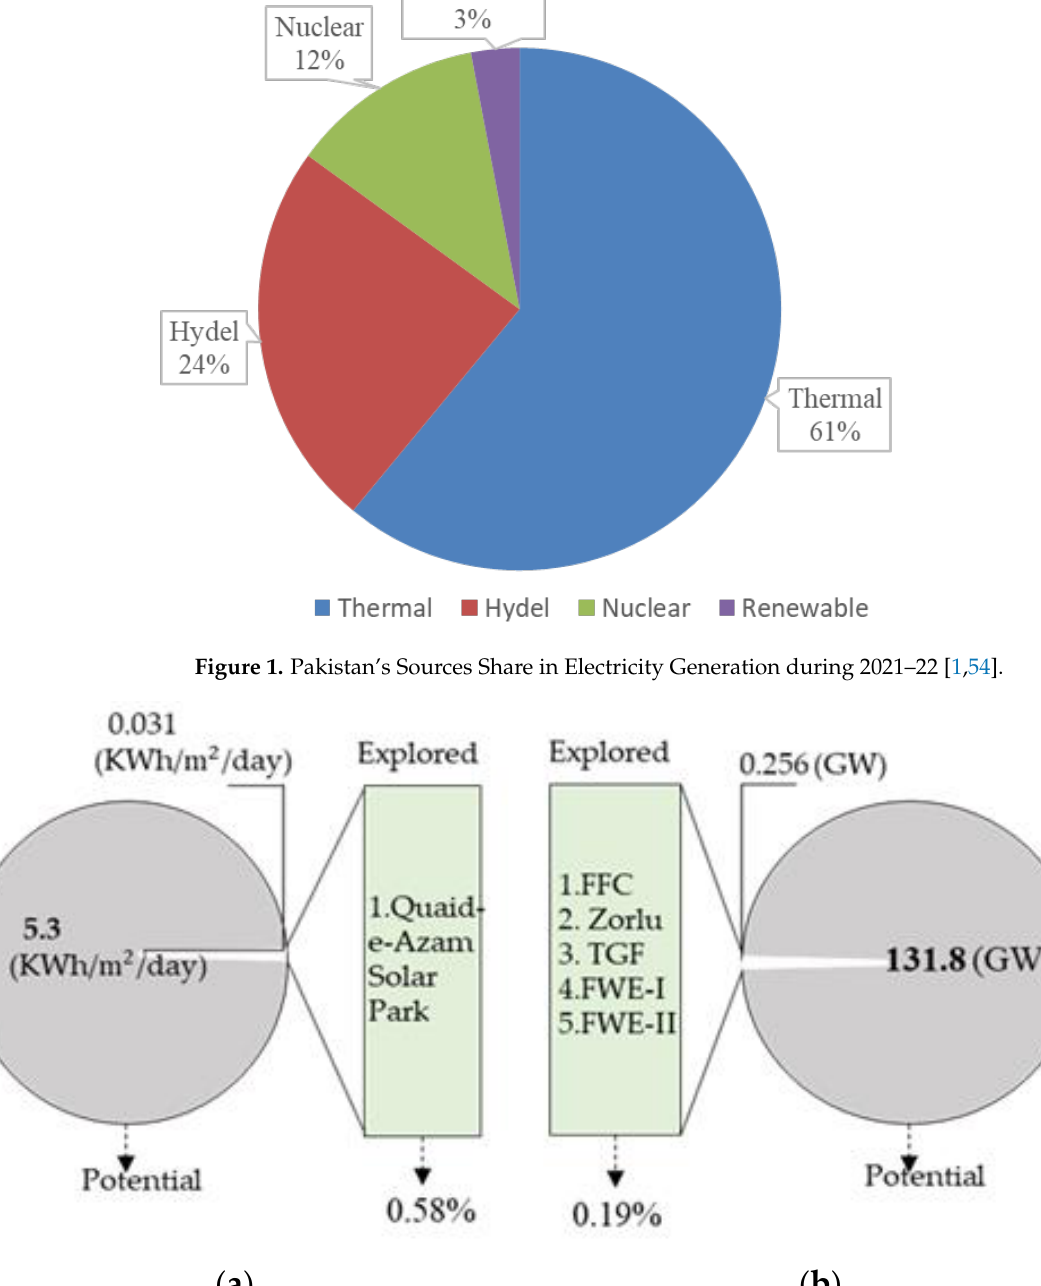
Figure 1. Pakistan’s Sources Share in Electricity Generation during 2021– 22 [1,54].